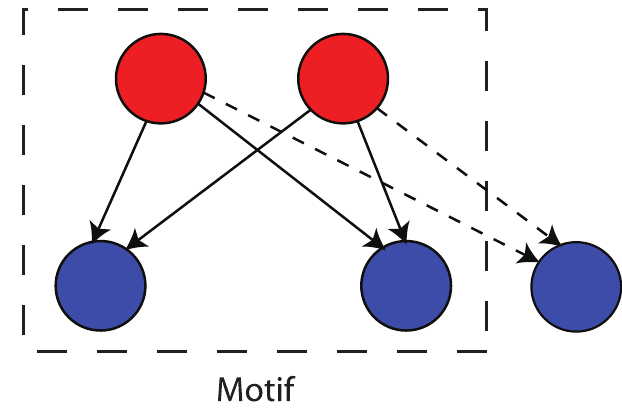
Figure 1. The Bi-Fan Motif and Its Extension to Bi-Fan Arrays Genes that encode TFs are coloured red, and genes that do not encode TFs are coloured blue. Accumulation of n common target genes (additional connections are represented by dotted lines) leads to formation of a bi-fan array containing n ( n (cid:2) 1) / 2 bi-fan motifs.